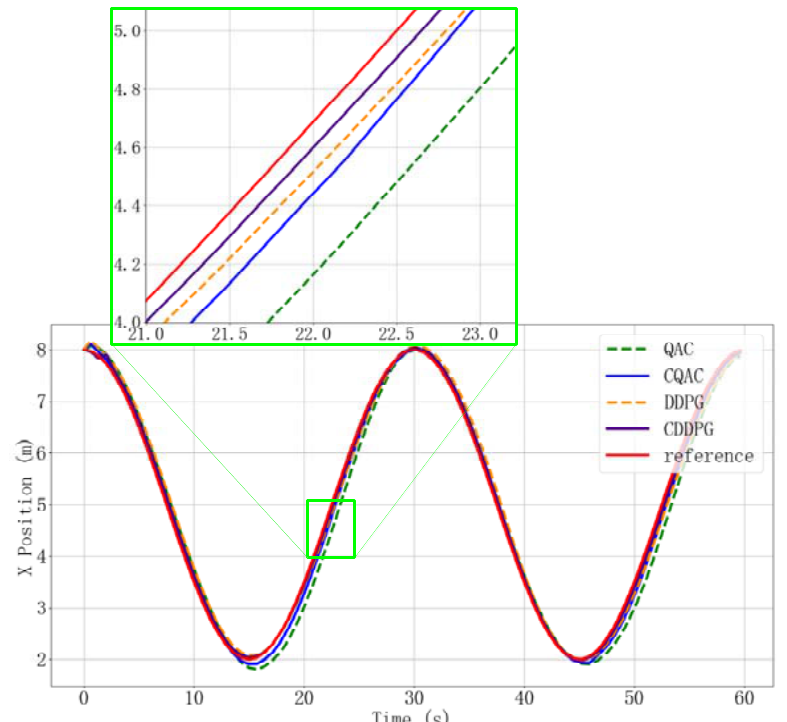
Figure 10. Spiral trajectory tracking curve of four algorithms.